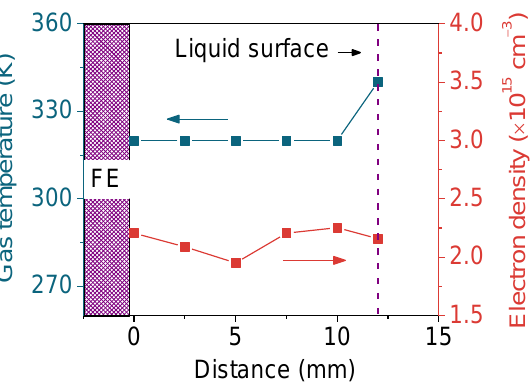
Figure 8. Gas temperature and electron density distribution in the axial direction.